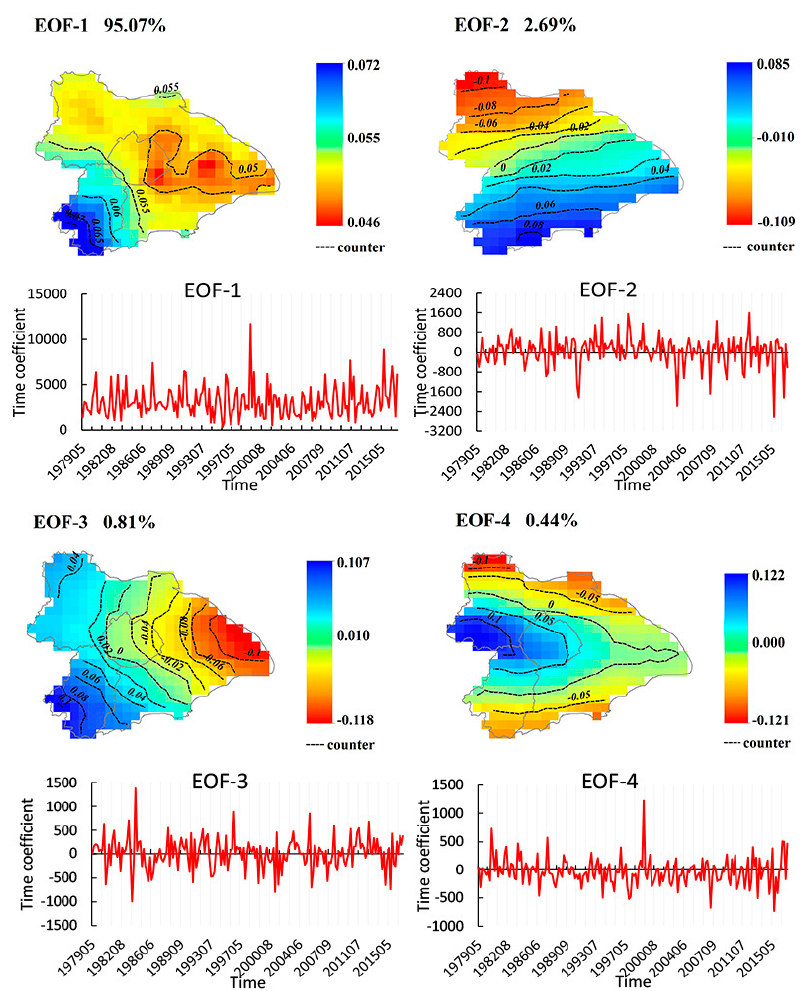
Figure 7. EOF analysis of gridded GWRMP at monthly scale in flood season (95% confidence level of North test).